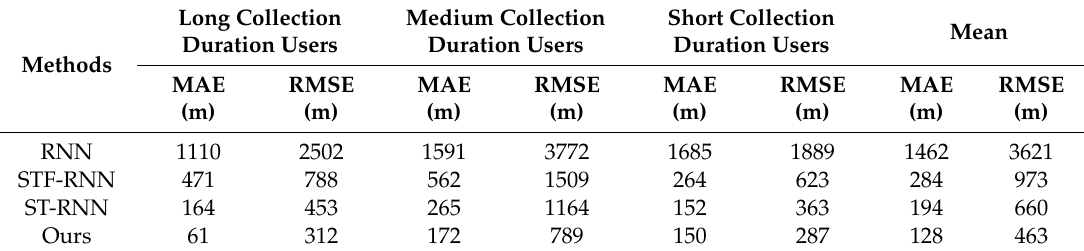
Table 4. Comparison of experimental results between users. MAE, mean absolute error; RMSE,